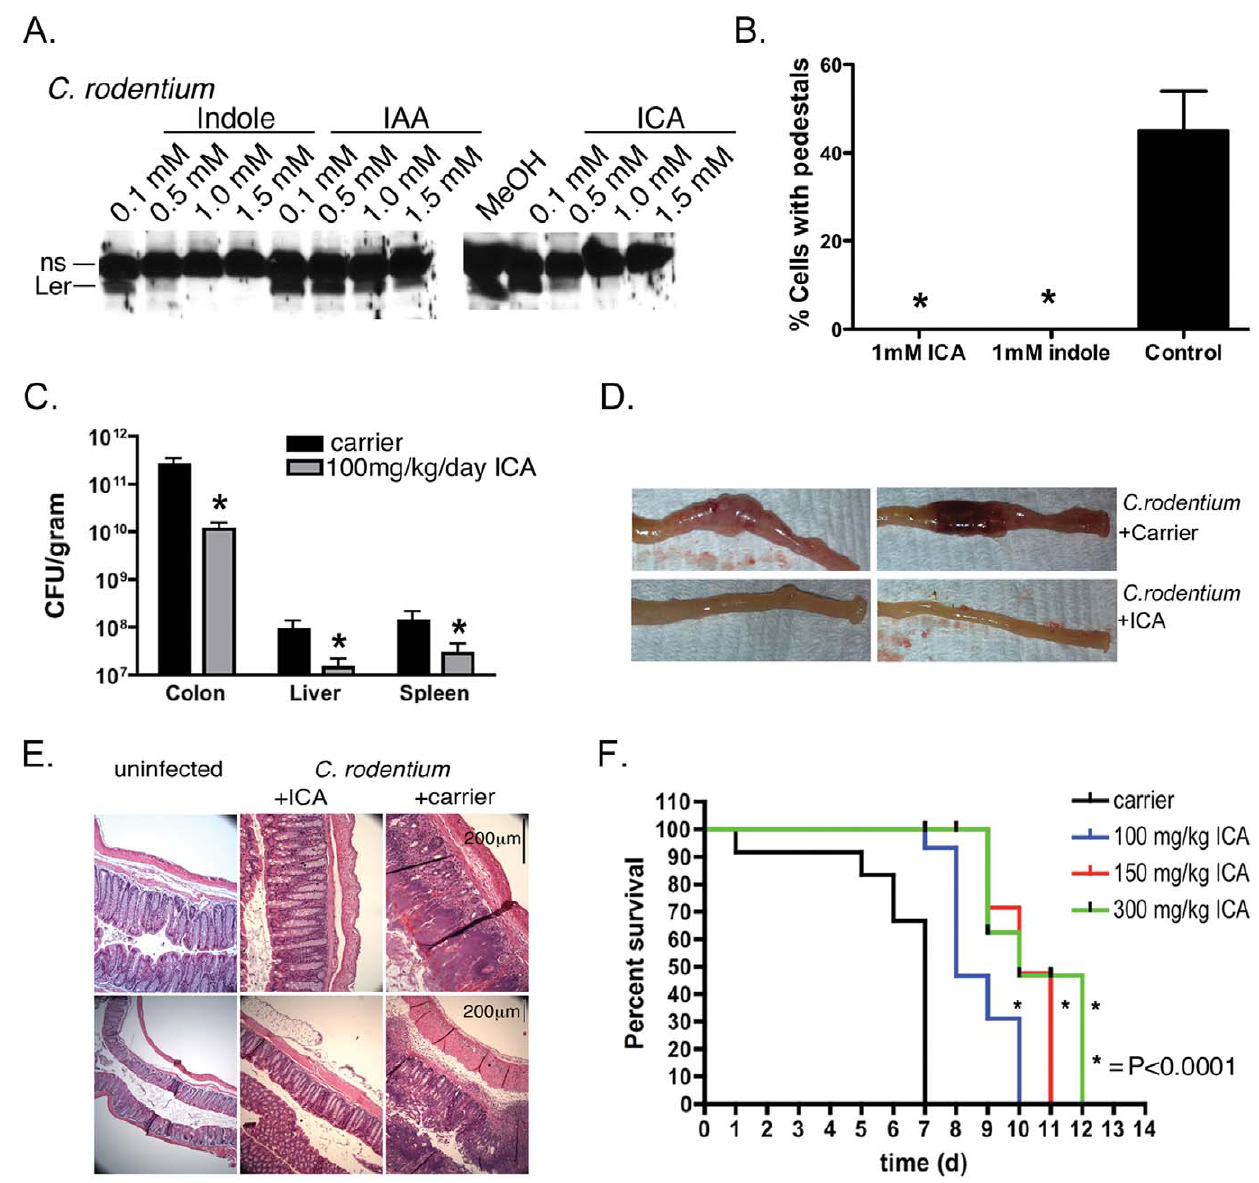
Figure 7. ICA reduces virulence of C.rodentiuminvitro and invivo . ( a ) Western analysis of Ler expression in C. rodentium treated with various concentrations of indole, ICA or IAA. The non-specific band recognized by the Ler pAb served as a loading control. ( b ) Quantitation of pedestal formation in 3T3 cells infected with C. rodentium in the presence of indole or ICA at various concentrations. Mean + / 2 SEM are shown; * corresponds to p , 0.01 with respect to untreated control. ( c ) CFU from colon, liver, and spleen of MyD88 2 / 2 mice infected for 7 days with C. rodentium and administered carrier (DMSO/5%Citric acid/PEG400, (30:35:35%)) or ICA (100 mg/kg/day) by oral gavage. Mean + / 2 SEM are shown; * corresponds to p , 0.01 with respect to untreated control. 8 mice were used for the control and 9 for the treatment with 100 mg/kg ICA. ( d ) Images of colons from animals left uninfected and treated with ICA (100 mg/kg/day) for 7 days, or infected with C. rodentium together with carrier or ICA. ( e ) H&E staining of colon sections from mice left uninfected, or infected with C. rodentium for 7d and administered either ICA (100 mg/kg/day) or carrier. ( f ) Survival curves of animals treated with carrier or 100 to 300 mg/kg/day ICA. Each curve is from a representative experiment (n=3 animals per condition), and each experiment was repeated 3 times. Statistical significance was determined by the Kaplan Meyer test. doi:10.1371/journal.pone.0054456.g007 signs of disease at a time when all the control animals had succumbed (7d post infection; Fig. 7f). Furthermore, the proba- bility of dying was reduced by 1.7 fold. These data were statistically significant using a Kaplan Meyer test (p , 0.0001). Collectively, these data suggest that ICA reduces morbidity and mortality of A/E pathogens in vivo.